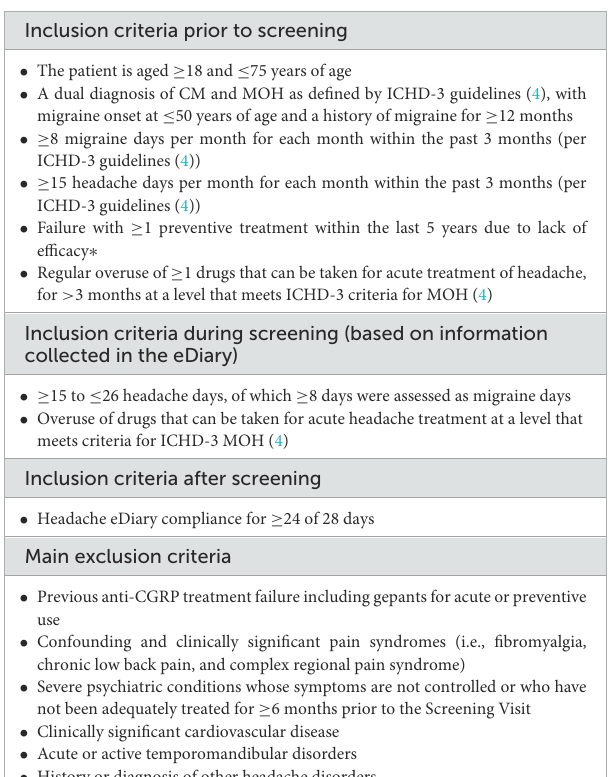
TABLE 1 Main inclusion and exclusion